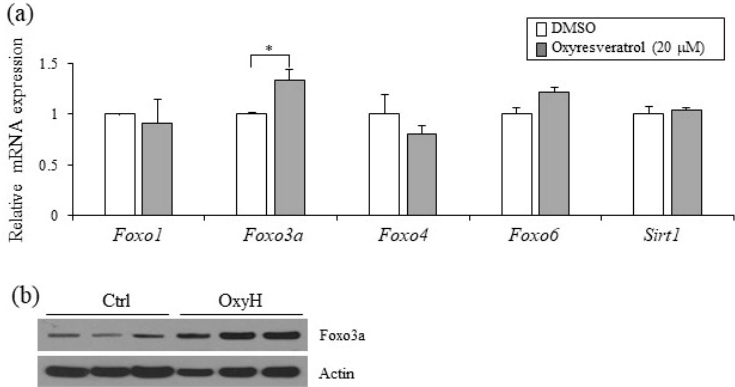
Figure 5. Selective induction of Foxo3a as an oxyresveratrol-regulated gene. ( a ) C3H10T1/2 adipocytes were treated with oxyresveratrol for 12 h and the regulatory effects on Foxo family and Sirt1 gene expression were analyzed. ( b ) In vivo regulation of Foxo3a protein in HFD-fed obese mice treated with vehicle control (Ctrl) or oxyresveratrol (OxyH) for 8 weeks. Expression of Foxo3a protein in iWAT of control and oxyresveratrol-treated mice was determined by Western blotting. Statistically significant differences were determined using Student’s t -test (* p < 0.05).